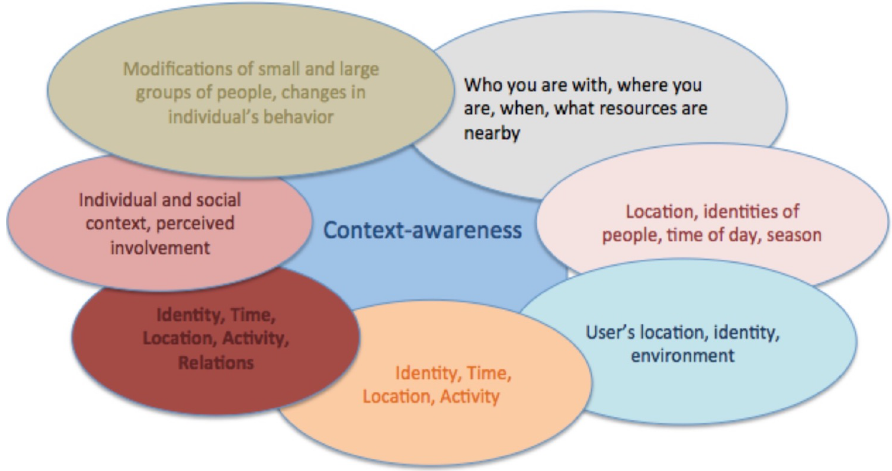
Figure 1. Definitions of the term context according to the bibliography covering the past 20 years